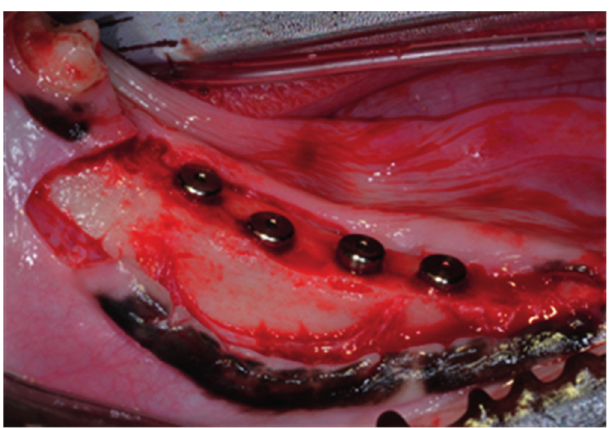
Figure 5. Implant placement. Implants were placed 4 mm apart using a ruler. Releasing incision was made for tension free structure of the